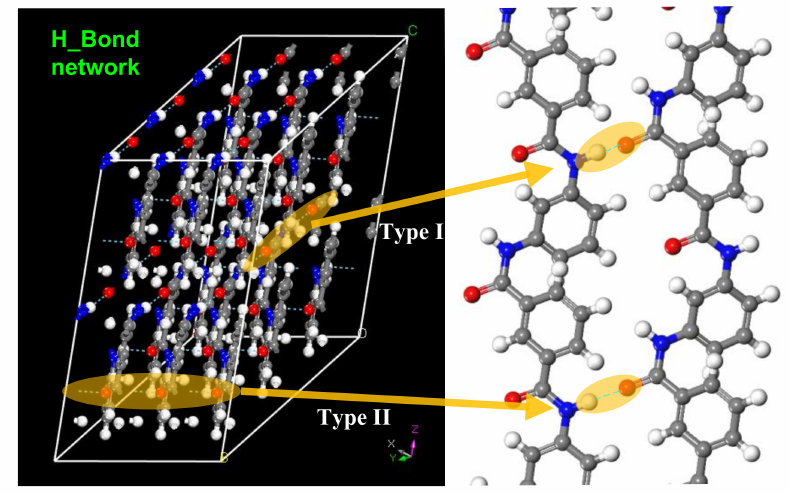
Figure 10. Hydrogen bonding network in the crystalline regions of meta-aramid